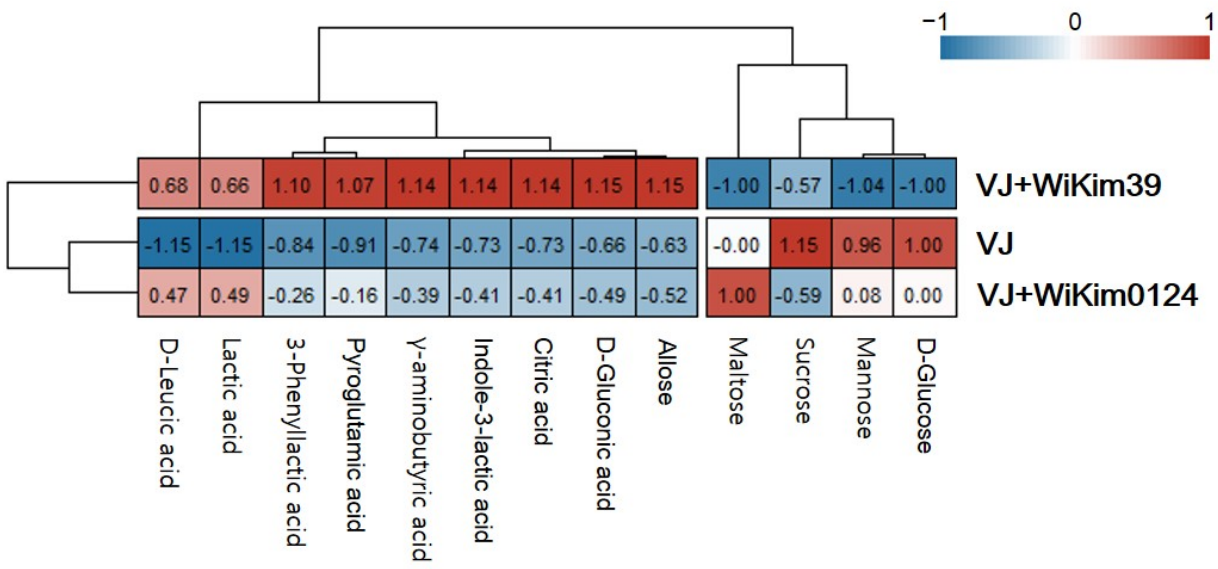
Figure 3. Heatmap. Distribution and concentration of phytochemicals among samples. Red boxes mean higher concentra- tions. Blue boxes mean lower